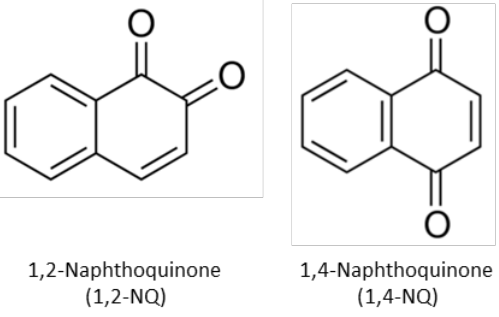
Figure 1. The chemical structures of 1,2-naphthoquinone (1,2-NQ) and 1,4-naphthoquinone (1,4- NQ).